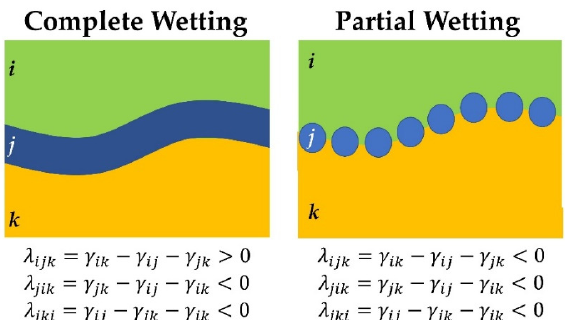
Figure 1. Schematic representation of the blend structure associated with complete and partial wetting morphologies in ternary polymer blends. The well-known harmonic mean equation can be used to determine the interfacial tension ( γ ) between different components ( i , j and k ) as follows [26]: 4𝛾 (cid:3036)(cid:3043) 𝛾 (cid:3037)(cid:3043) 4𝛾 (cid:3036)(cid:3031) 𝛾 (cid:3037)(cid:3031) 𝛾 (cid:3036)(cid:3037) = 𝛾 (cid:3036) + 𝛾 (cid:3037) − − (2) 𝛾 (cid:3036)(cid:3031) + 𝛾 (cid:3037)(cid:3031) 𝛾 (cid:3036)(cid:3043) + 𝛾 (cid:3037)(cid:3043) where γ i and γ j represent the surface tensions of component ( i ) and ( j ), respectively, while γ p and γ d are, respectively, the polar and dispersive components of surface tension ( 𝛾 (cid:3039) = 𝛾 (cid:3039)(cid:3031) + 𝛾 (cid:3039)(cid:3043) ) calculated from the contact angle (Equations (1) and (2)) [26]. Based on data ob- tained from the sessile drop method, the surface tension of PLA, PA11, PEO and PBAT, as well as the interfacial tension values and the spreading coefficients, are reported in Table 1. Table 1. Surface tension and interfacial tension values at 25 °C calculated from contact angle and spreading coefficients (all values are in mN/m).